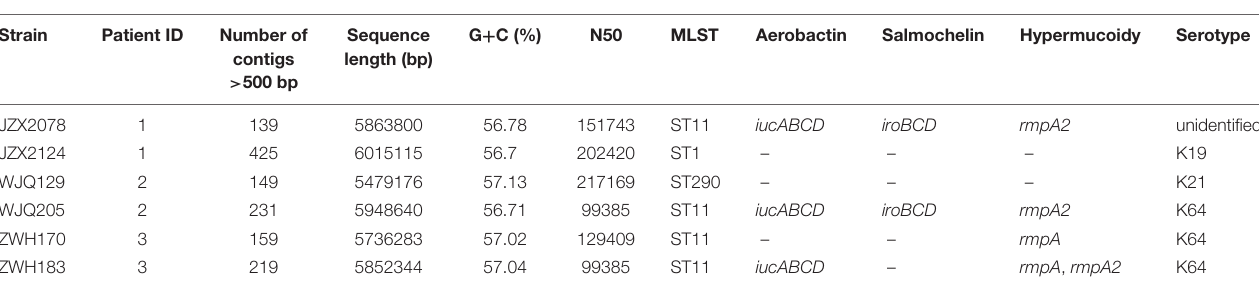
TABLE 1 | Sequence information for rectal CRKP isolates from the three